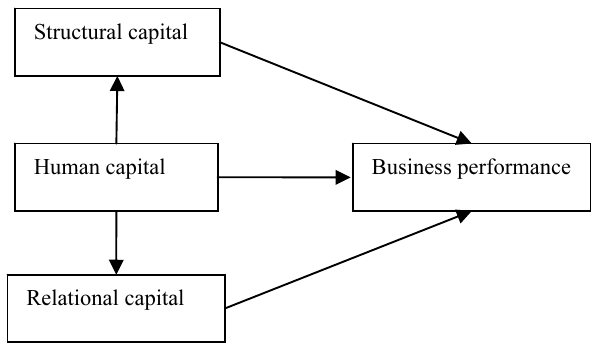
Fig 1. Theoretical model of this research